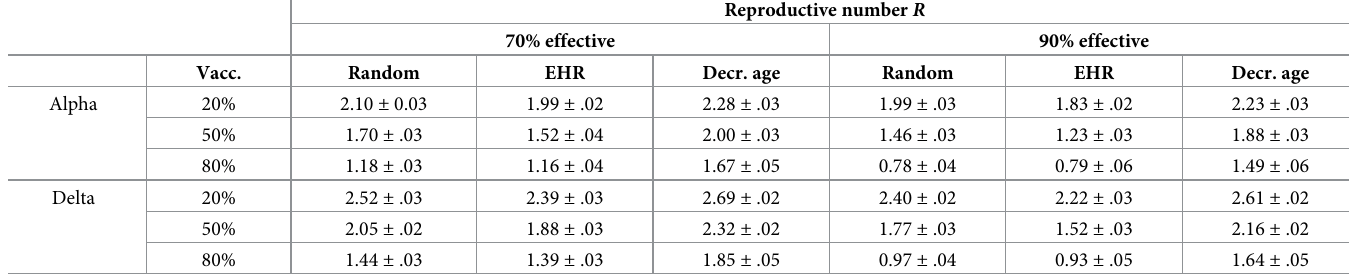
Fig 1. Effect of vaccine deployment on the reproductive number, according to strategy and variant. Epidemic reproduction number as a function of vaccinated fraction of population and vaccine efficiency for each of the four presented strategies, assuming a base reproduction number of R 0 = 2.5 for the COVID-19 Alpha variant and R 0 = 3 for Delta. Each data point (mean and standard error bar) is based on 20 duplicate simulations. https://doi.org/10.1371/journal.pone.0263155.g001 Table 1. Effect of vaccine deployment on R , the reproductive number, in response to vaccination strategies for COVID-19 Alpha and Delta variants. Epidemic repro- duction number as a function of vaccinated fraction of population and vaccine efficiency for each of the four presented strategies, assuming a base reproduction number of R 0 = 2.5 for the COVID-19 Alpha variant and R 0 = 3 for the Delta variant. Each data point (mean and standard error) is based on 20